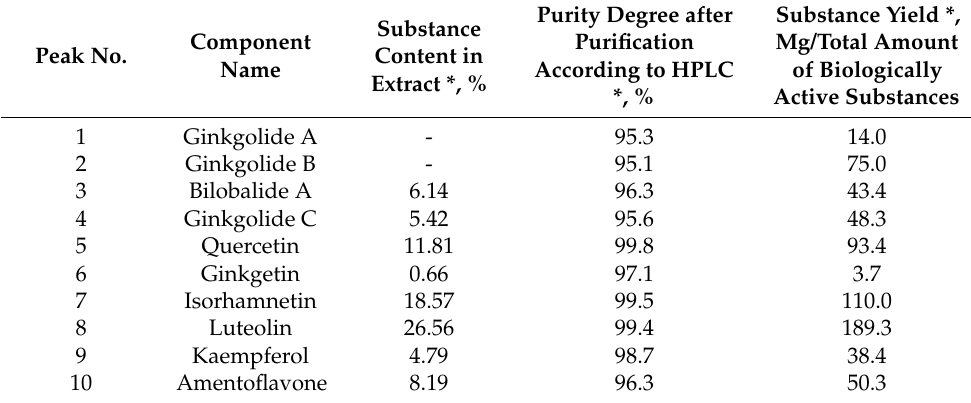
Table 3. Mass yield of extractives